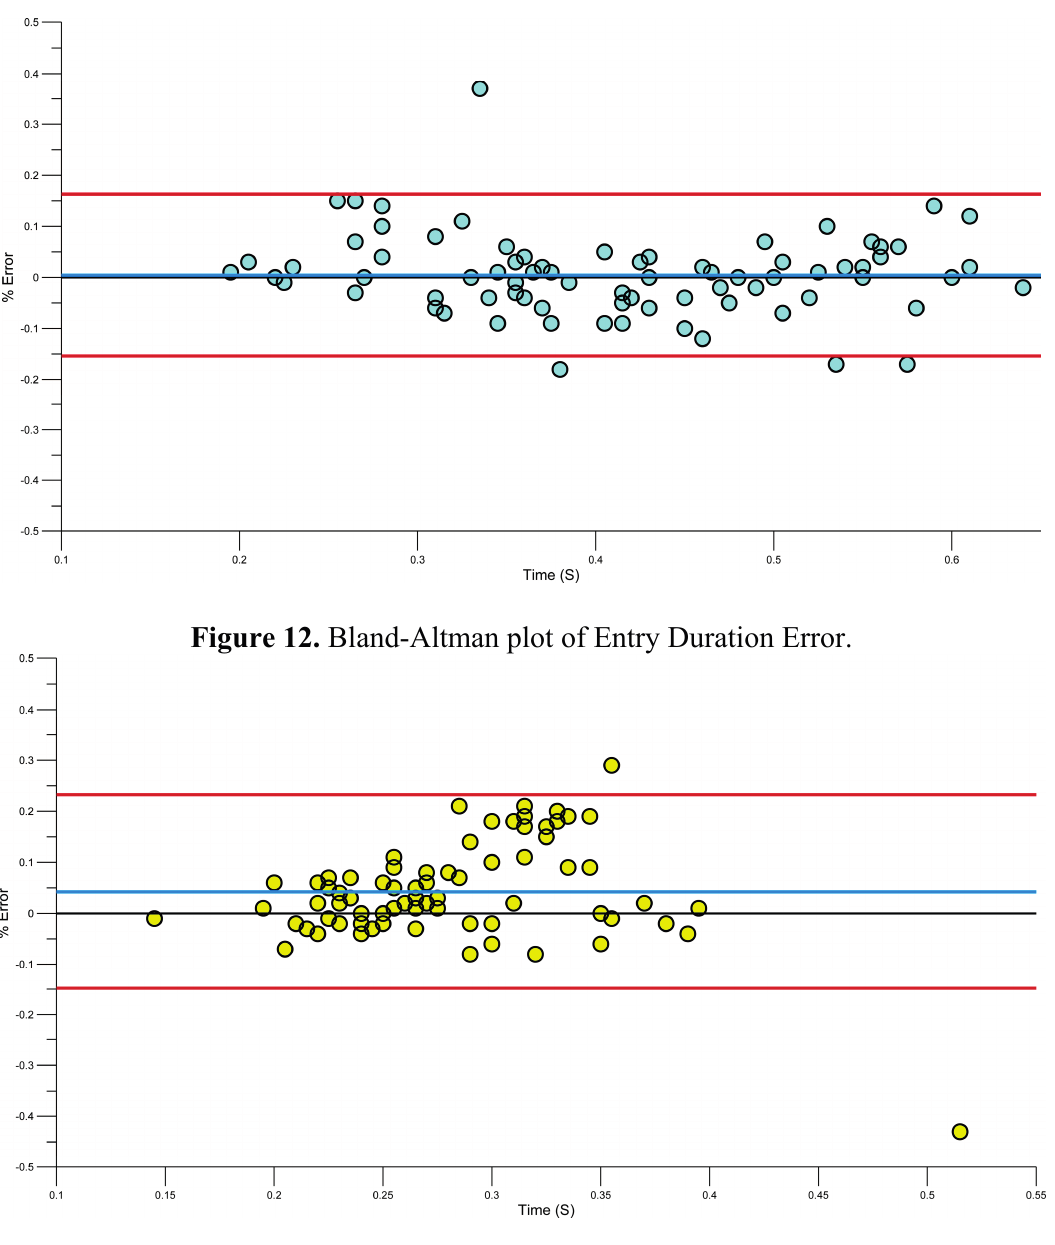
Figure 13. Bland-Altman plot of Pull Duration